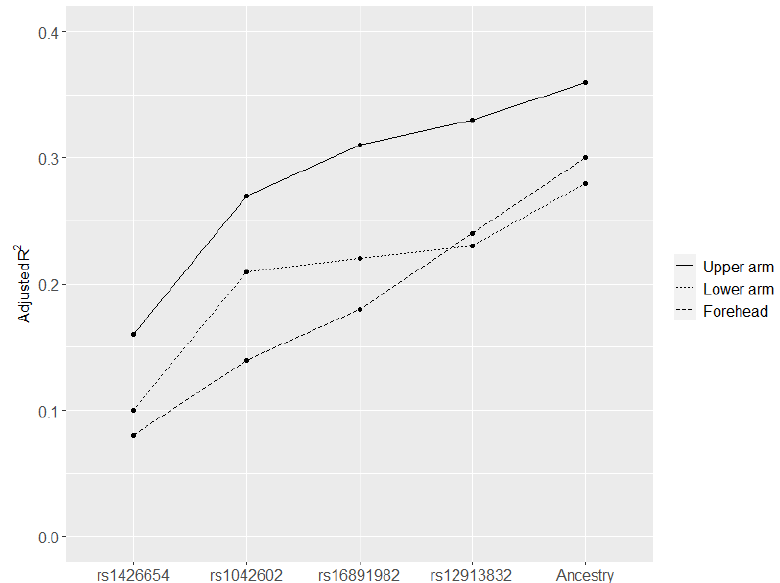
Figure 3. Cumulative correlations between (1) four SNPs and ancestry and (2) upper arm, lower arm, and forehead pigmentation. The SNPs were ranked based on their correlations with skin color (adjusted R 2 ). Ancestry is the proportion of Sub-Saharan African and European ancestry.